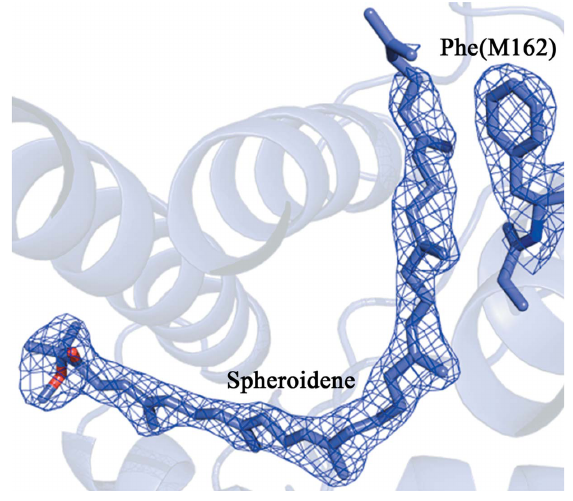
Figure 6 Fragment of the electron density map of the Rba. sphaeroides RC structure in the carotenoid binding site. The sample co-crystallized with carotenoid in the LSP (2.1 A˚ resolution, 1.6 (cid:2)